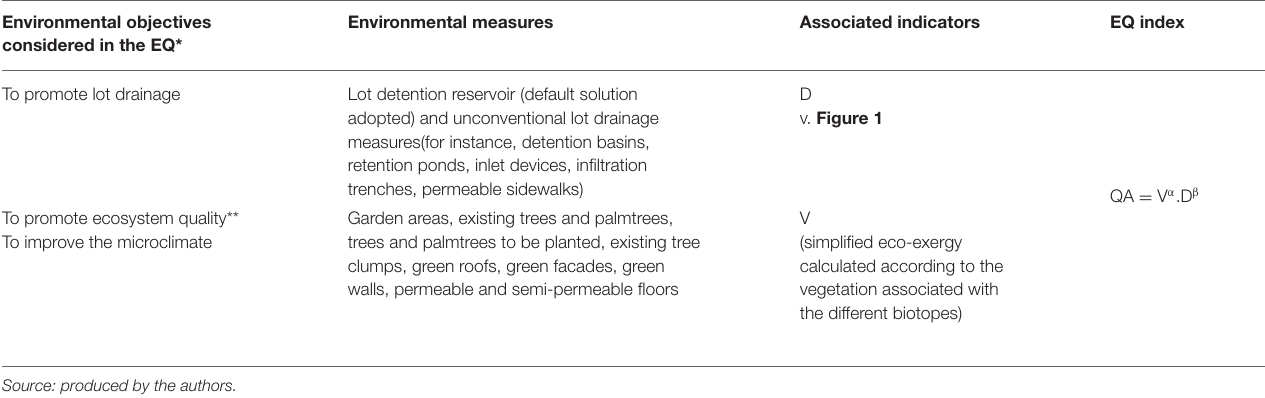
TABLE 1 | Environmental objectives and indicators. Environmental objectives considered in the